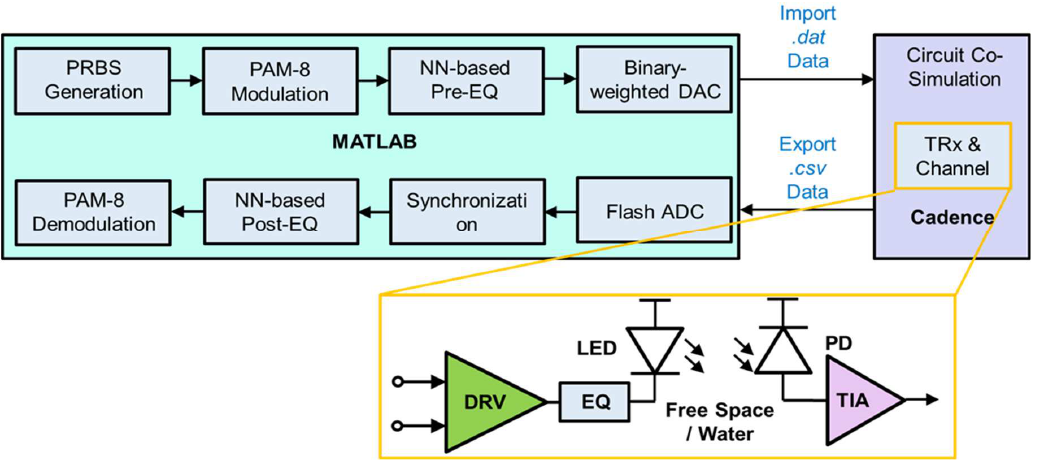
Figure 10. Architecture of proposed VLC system with NN-based equalizations.